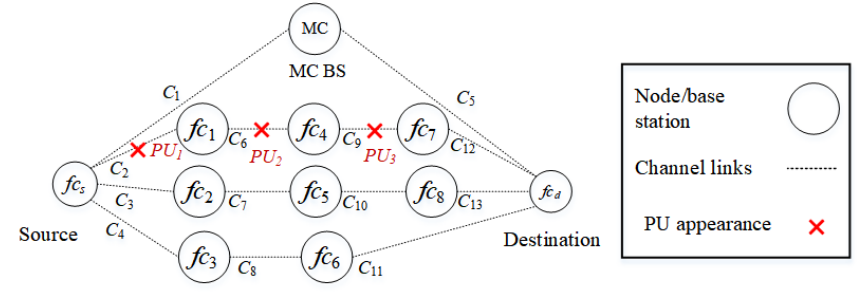
Figure 6. Scenario 1: The appearance of PUs in route k 3 interfere with channels c 2 , c 6 , and c 9 .